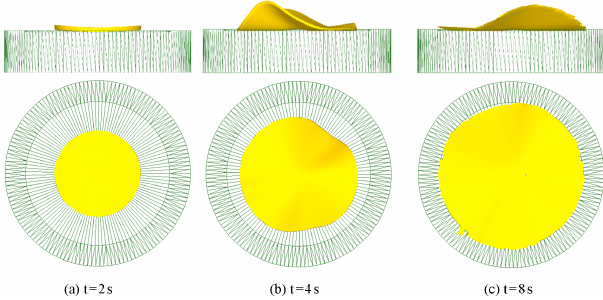
Figure 9. Deformation process of rotary forging with DSRs of a disc under the first deformation